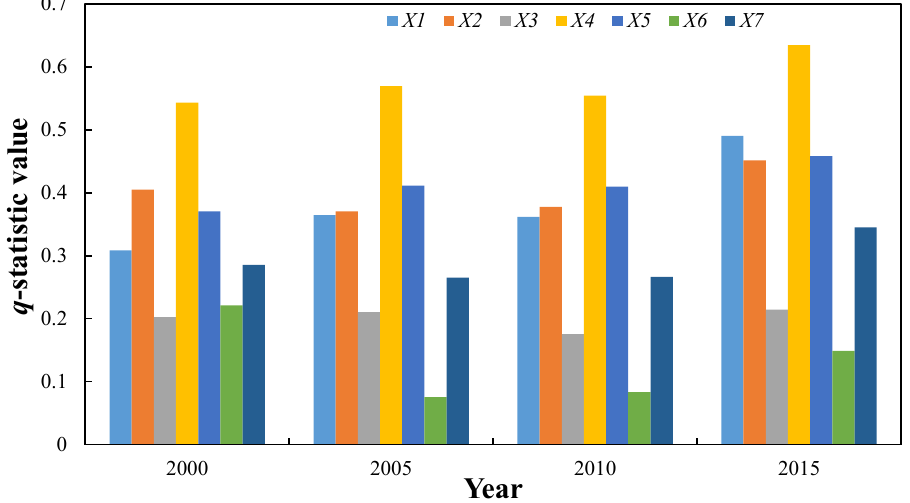
Figure 3. Contributions of controlling factors from 2000 to 2015.